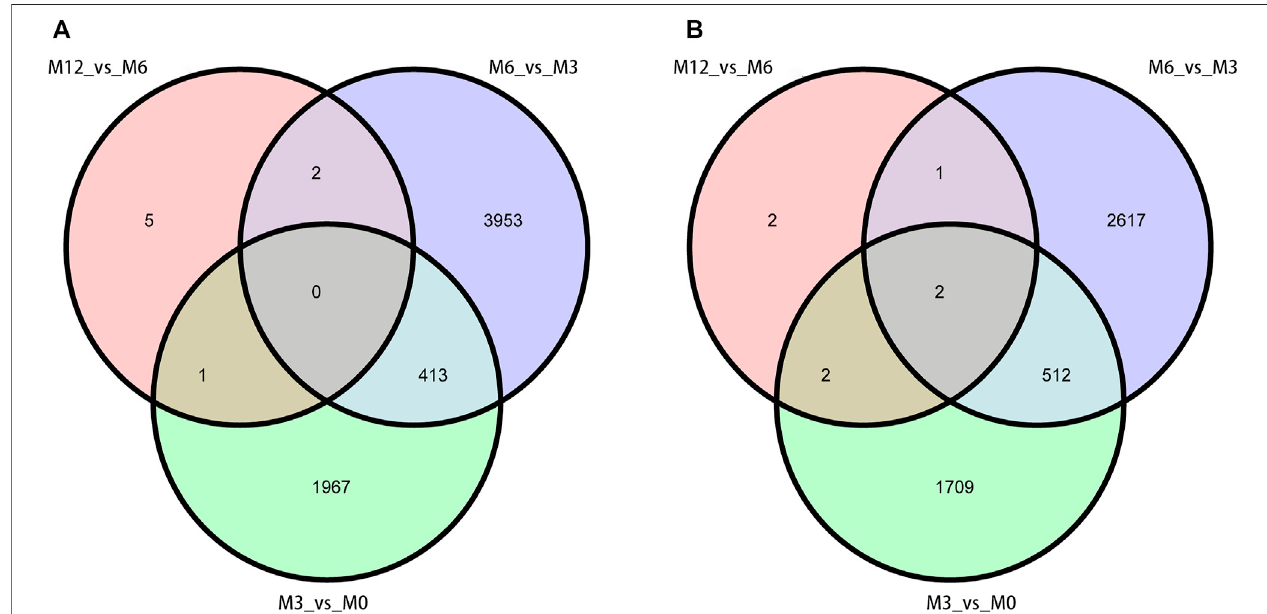
FIGURE 4 | Six differential expressed genes were validated using qPCR. Data shown are the mean ± SEM. Same letter indicates that the difference is not signi fi cant; different letters represent differences. Three biological replicates were used.